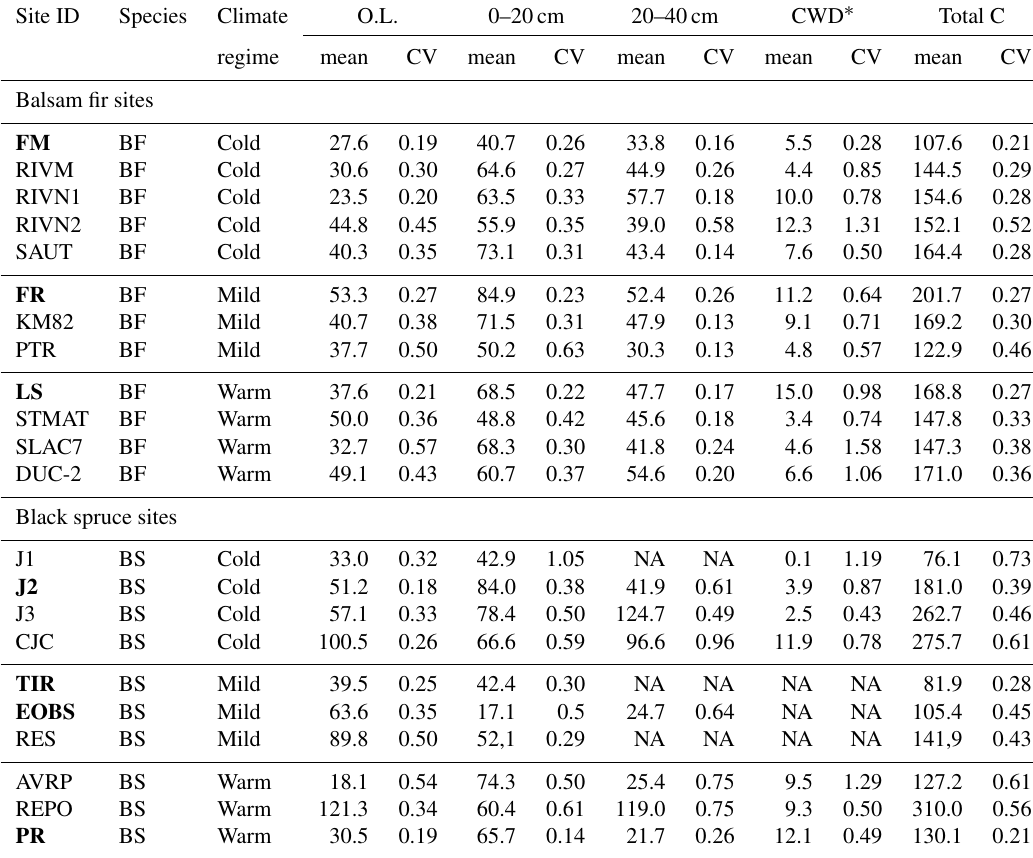
Table 2. Soil carbon stock (tCha − 1 ) mean and coefficient of variation (CV) for the study sites. O.L. stands for organic layer (FH) and 0–20 and 20–40cm for the soil depth increments of mineral soil samples. ∗ CWD: coarse woody debris. Total C: total of all listed pools. Intensively studied sites are marked in bold characters. NA: not available.